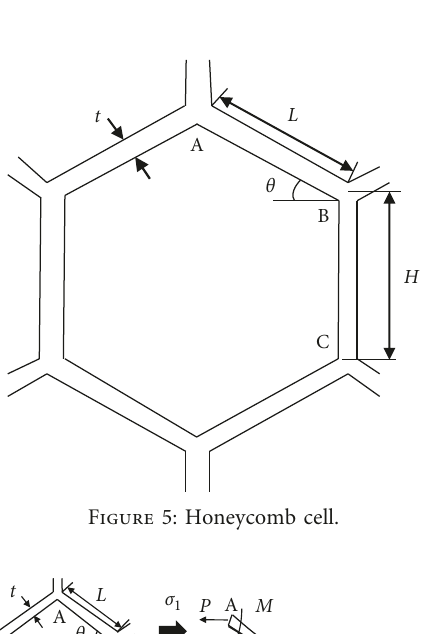
Figure 4: Multilayered equivalent.